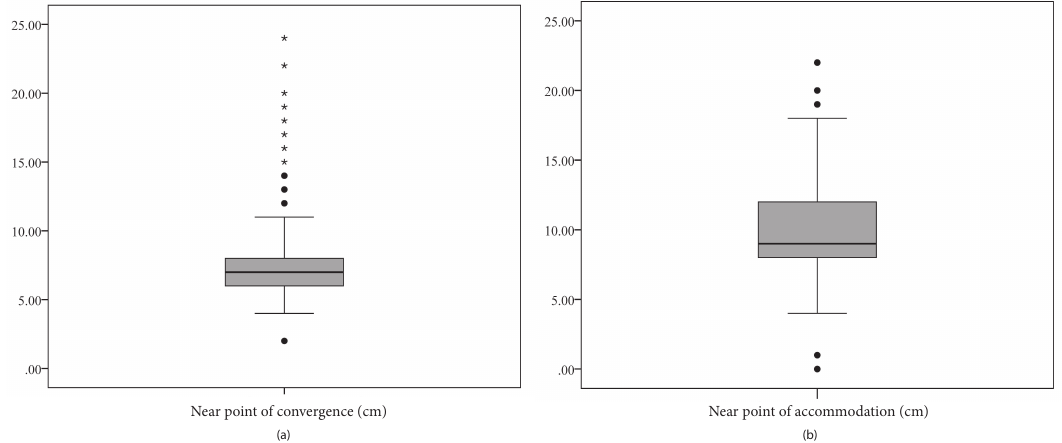
Figure 1. (a) The distribution of the near point of convergence (b) and near point of accommodation in university students.